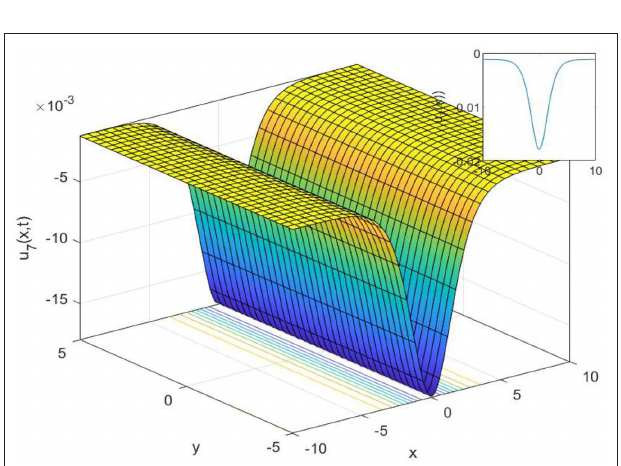
FIGURE 7 | The 3D, 2D, and contour surfaces of Equation (33) using A 1 0.2, α 0.9, and ǫ 0.6. = = =